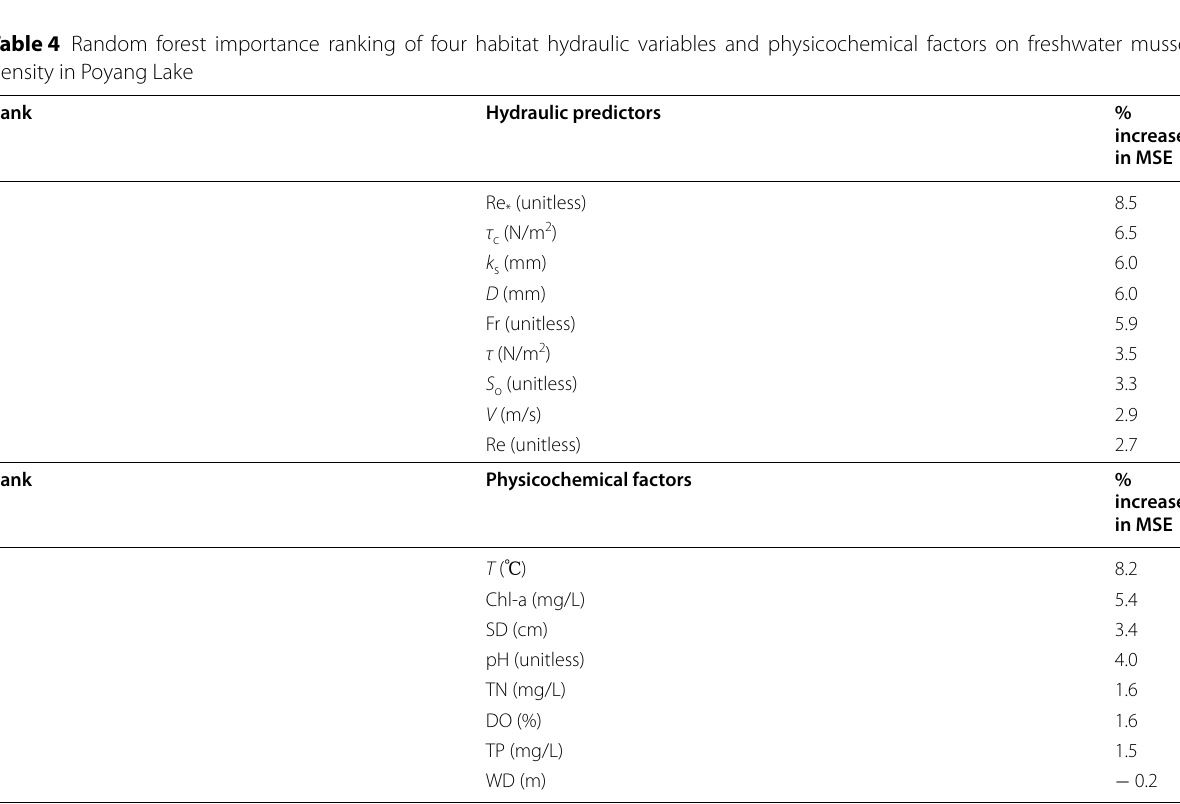
Nodularia douglasiae and Lanceolaria lanceolata were also significantly correlated with water depth (Fig. 5c). Sinosolenaia oleivora was significantly correlated with transparency, total nitrogen and total phosphorus